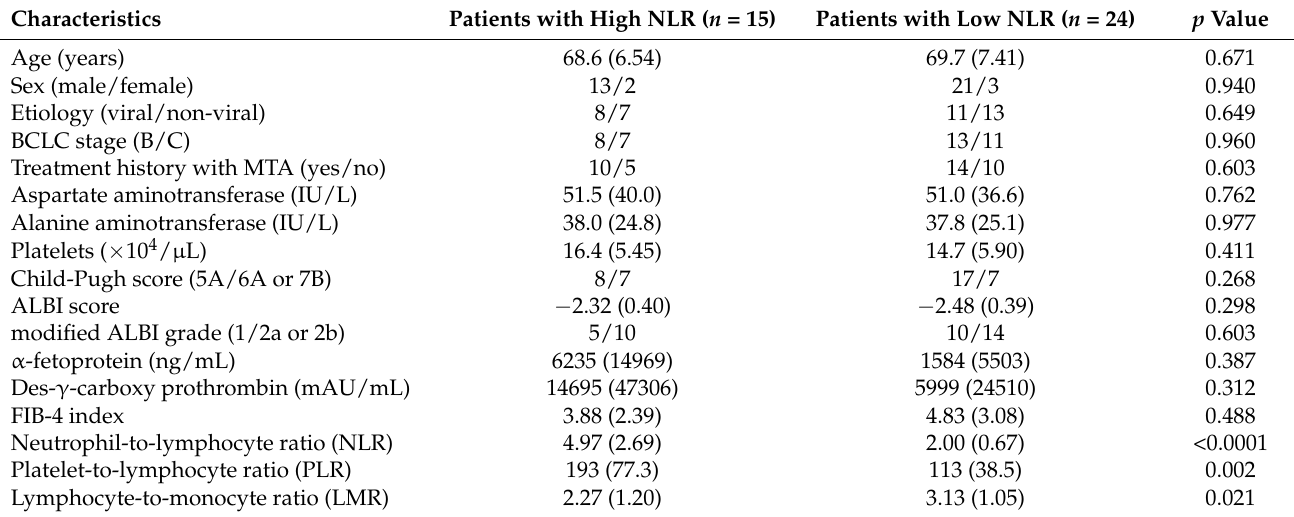
Table 4. Comparison of pretreatment factors between groups of patients with high neutrophil-to-lymphocyte ratio (>3.21) and low neutrophil-to-lymphocyte ratio ( ≤ 3.21).